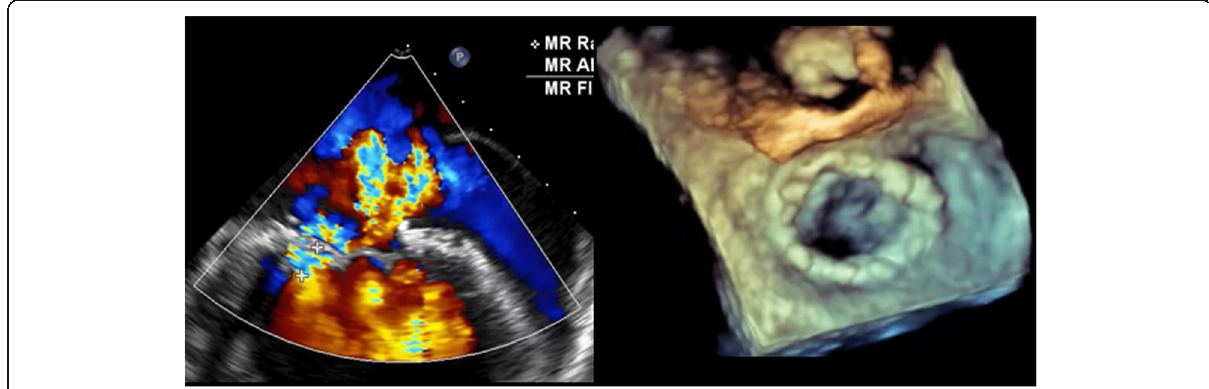
Fig. 2 Pre-operative transoesophageal echocardiogram (TOE) was performed to assess valve function and assess for vegetations. TOE showed the posterior leaflet of the previously repaired mitral valve to significantly shortened and thickened but no clear signs of infective endocarditis. Superimposed Doppler assessment demonstrates severe mitral regurgitation and the 3-dimensional (3D) re-construction demonstrates the restriction of the valve, both secondary to this shortened and thickened posterior